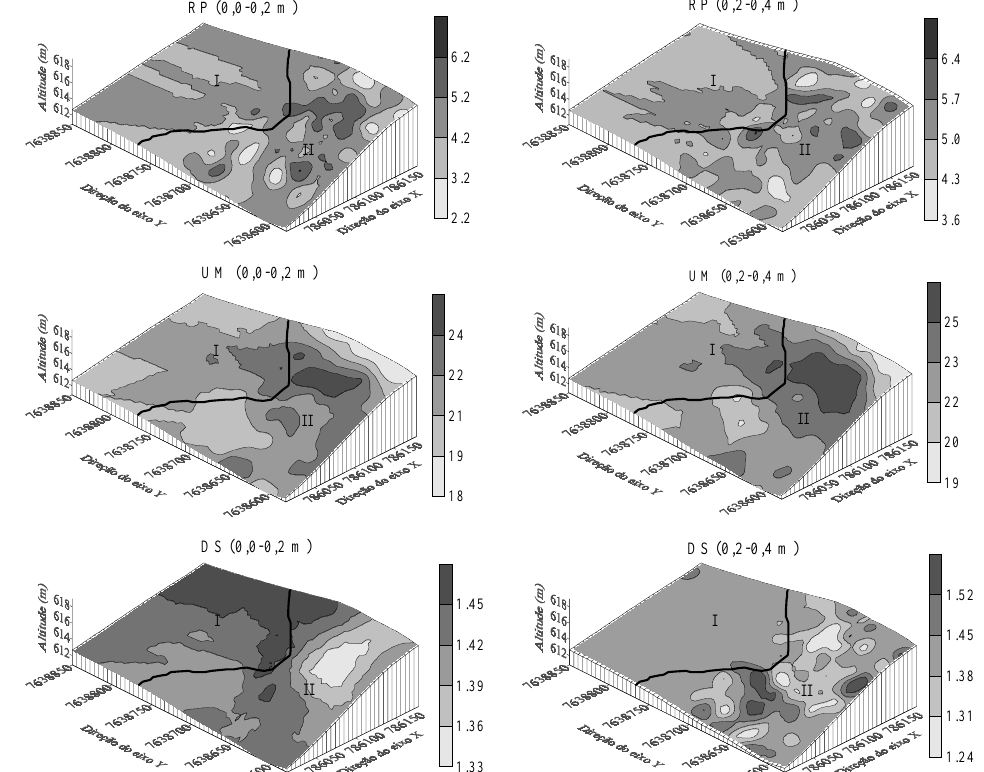
Figura 3. Distribuição espacial da resistência à penetração - RP (MPa), umidade do solo - UM (kg kg -1 ) e densidade do solo - Ds (kg m -3 ) de amostras coletadas na malha nas profundidades de 0,0–0,2 m e 0,2– 0,4